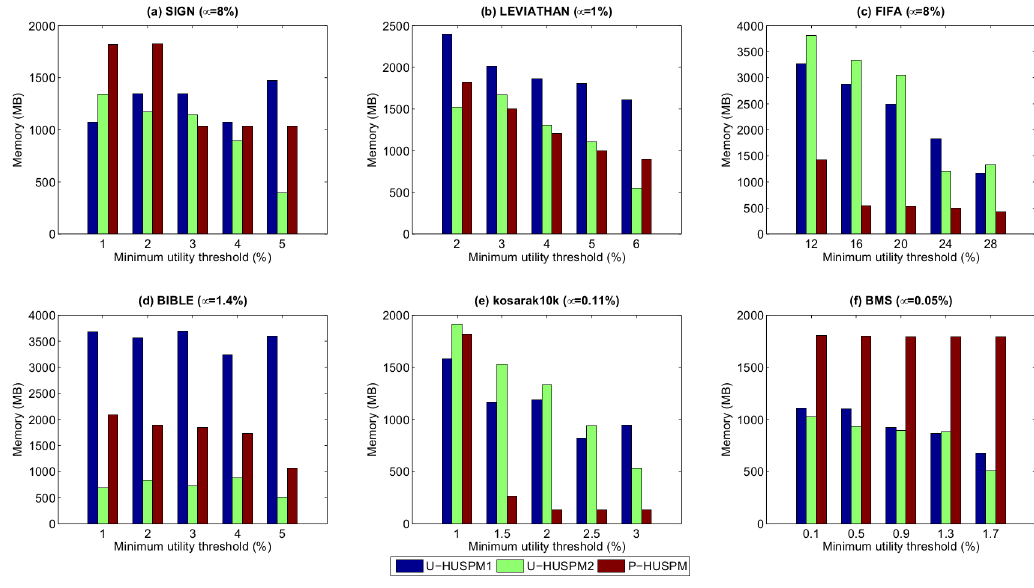
Fig 5. Memory usage for a fixed μ when ε is